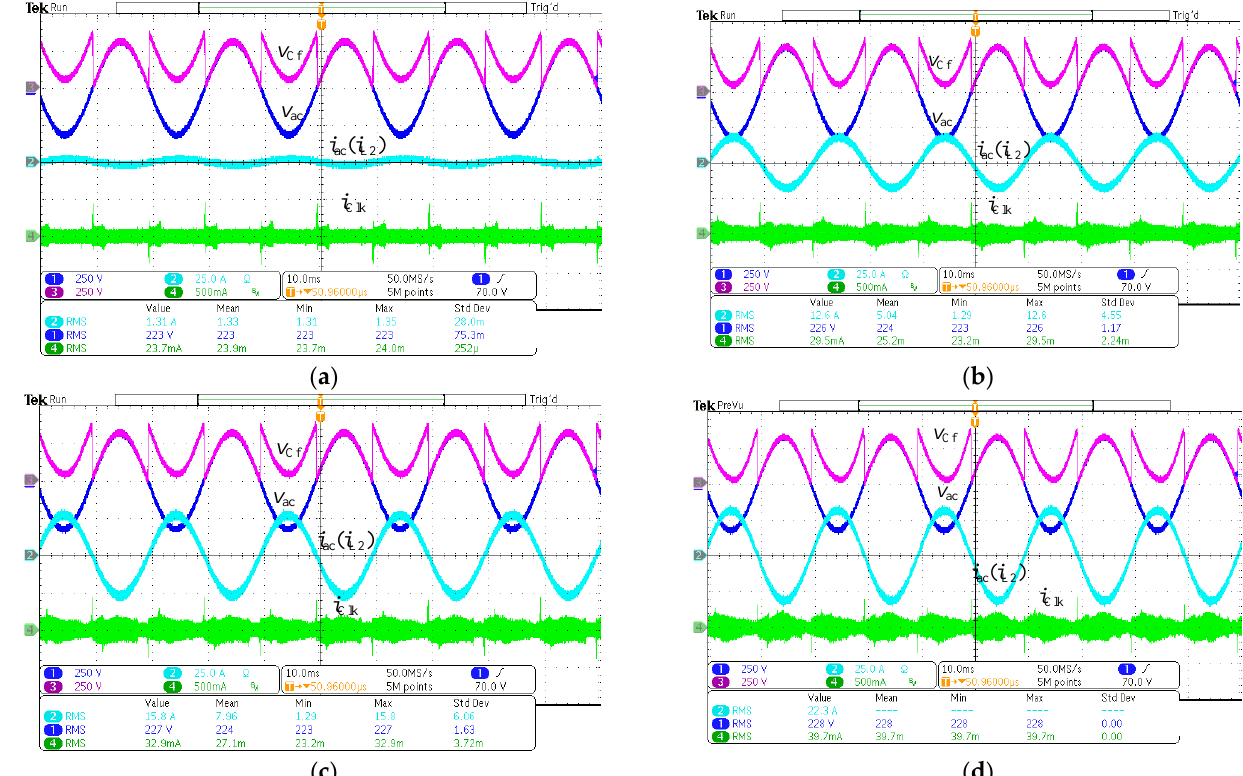
Figure 12. Steady-state waveforms of PFC at Inverter mode. ( a ) 0.5 kW, ( b ) 1 kW, ( c ) 2.5 kW, and ( d ) 5 kW.